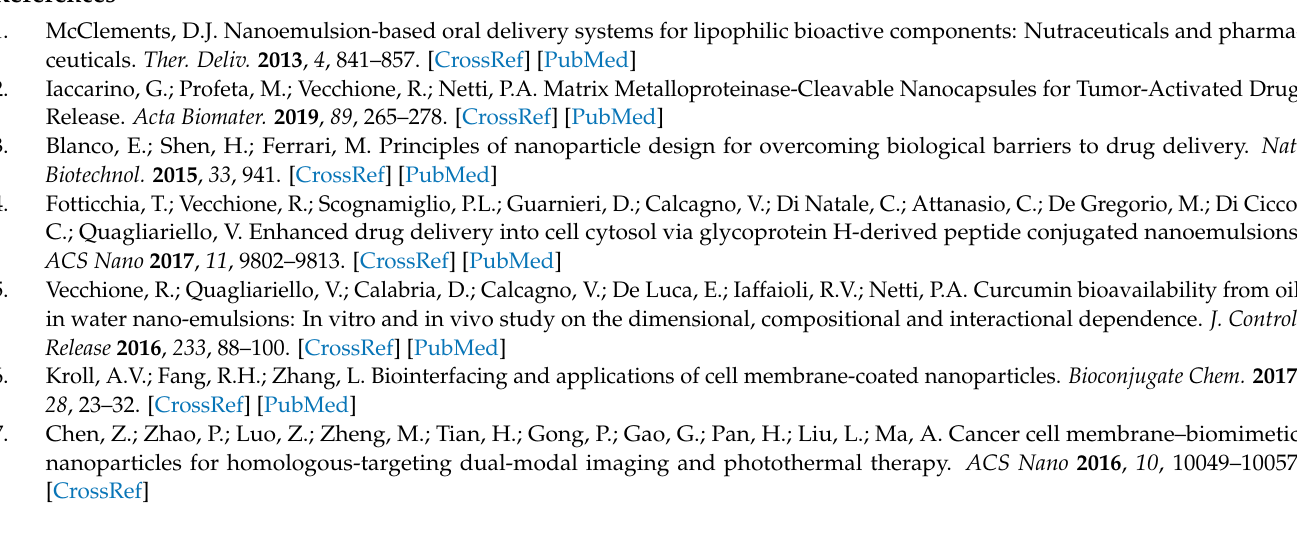
purification process. Figure ( B ) is a zoom in of Figure ( A ). Figure S2: Overlay of CD spectra of: pink) bare membrane after extraction and purification processes (371.1 µ g) and blue) cell membrane proteins deposited on Ct-NE (150 µ g). Figure S3: Cell membrane quantification by BCA assay. Titration curve. Table S1: Size, PDI and ζ -potential data of Ct-NEs and CM-NEsoSome. Table S2: Size and PDI of CM-NEsoSome over time obtained by DLS analysis. Data are expressed as mean ± SD ( n = 3). Figure S4: STED analysis of Ct-NE (A,B) and CM-NEsoSome (C,D). (A,C) STED images, (B,D) Deconvolution spectra analysis by ImageJ ® software extracted respectively from images (A,C). Figure S5: ζ -potential (mV) distribution of U87-MG